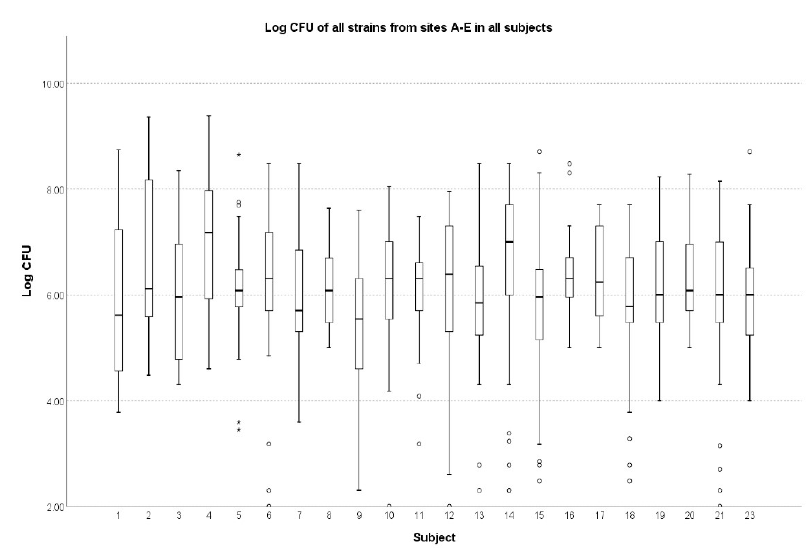
Int. J. Environ. Res. Public Health 2023 , 20 , x